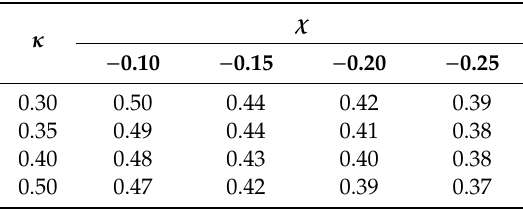
Table 5. Values of γ SF , NSAS / γ SF , CIS Figure 14. Time series of shear force for uncontrolled underground structure (US), controlled by conventional isolation system (US-CIS) and controlled by negative-stiffness amplification system (US-NSAS)-based isolation system. ( a ) Port Island and ( b ) HIK station records. Figure 13. Ratios of shear forces between NSAS-based isolation system and CIS: ( a ) 